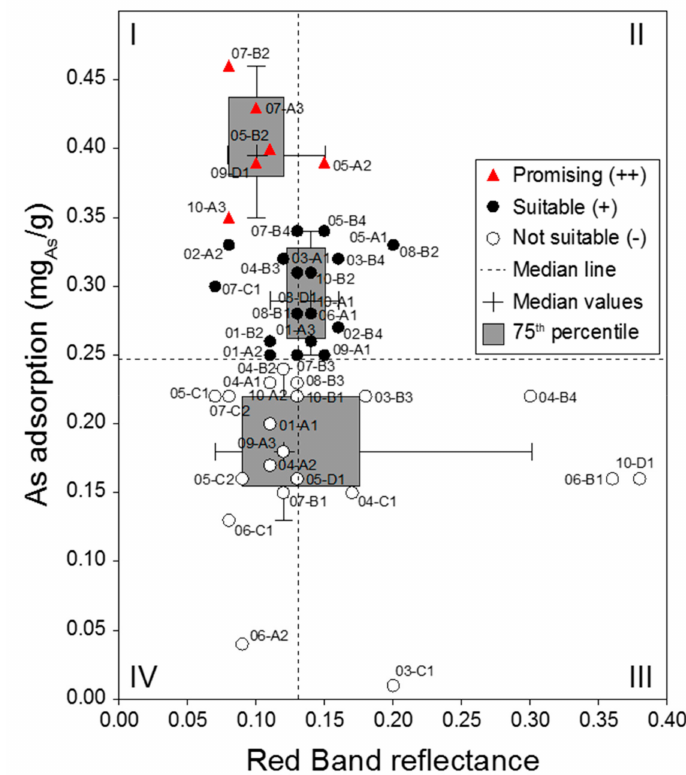
Figure 2. Bi-directional box plots of Red Band reflectance and As adsorption (mgAs / g) of sampled rock wastes, coded as in Figure 1. The overall median values of the two parameters (dashed lines) were used to discriminate samples with relatively lower and higher transmittance and adsorption potential (i.e., not suitable (-), suitable ( + ), and promising ( ++ ) for As removal). Samples were divided into four quadrants according to their characteristics. Quadrant I: high As adsorption and low Red Band reflectance (26% of samples); Quadrant II: High As adsorption and high Red Band reflectance (30% of samples): Quadrant III: low As adsorption and high Red Band reflectance (19% of samples) and Quadrant IV: low As adsorption and low Red Band reflectance (26% of